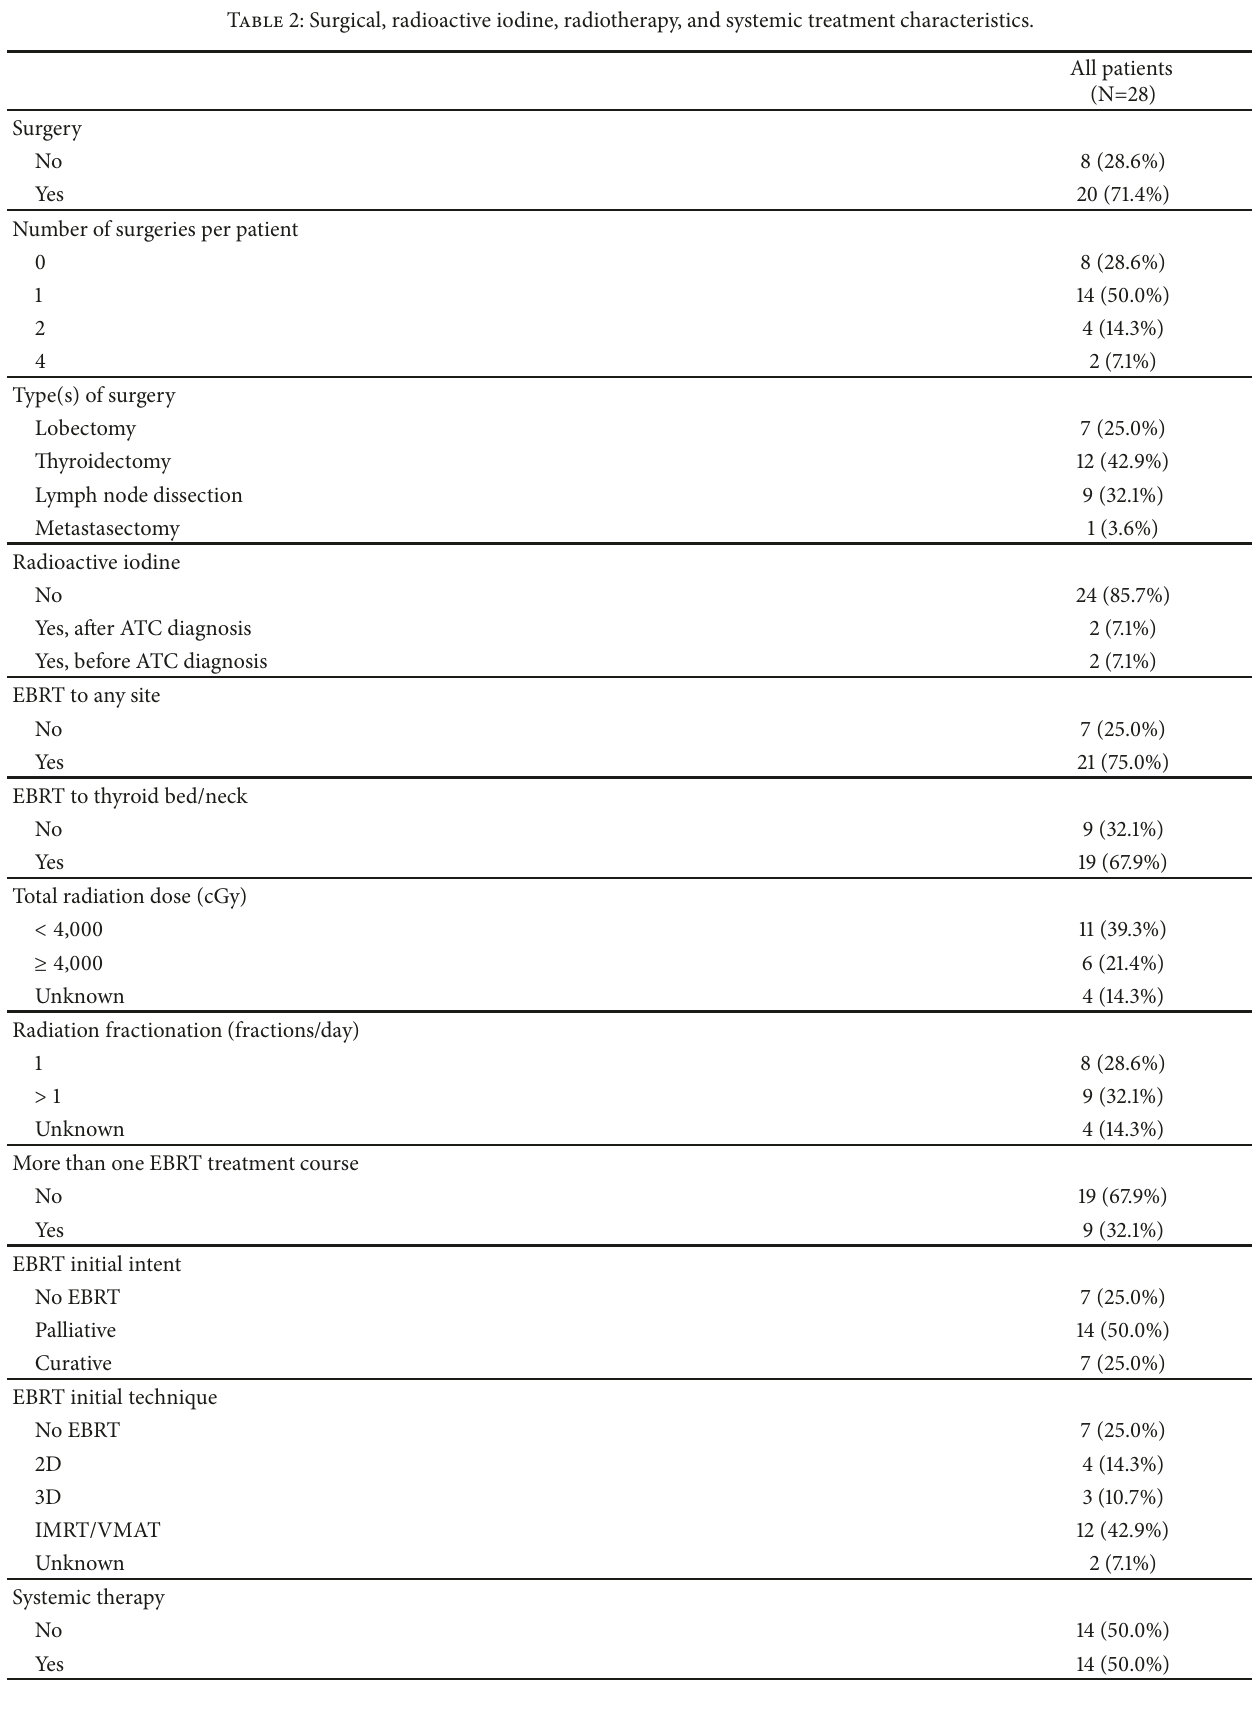
Table 2: Surgical, radioactive iodine, radiotherapy, and systemic treatment